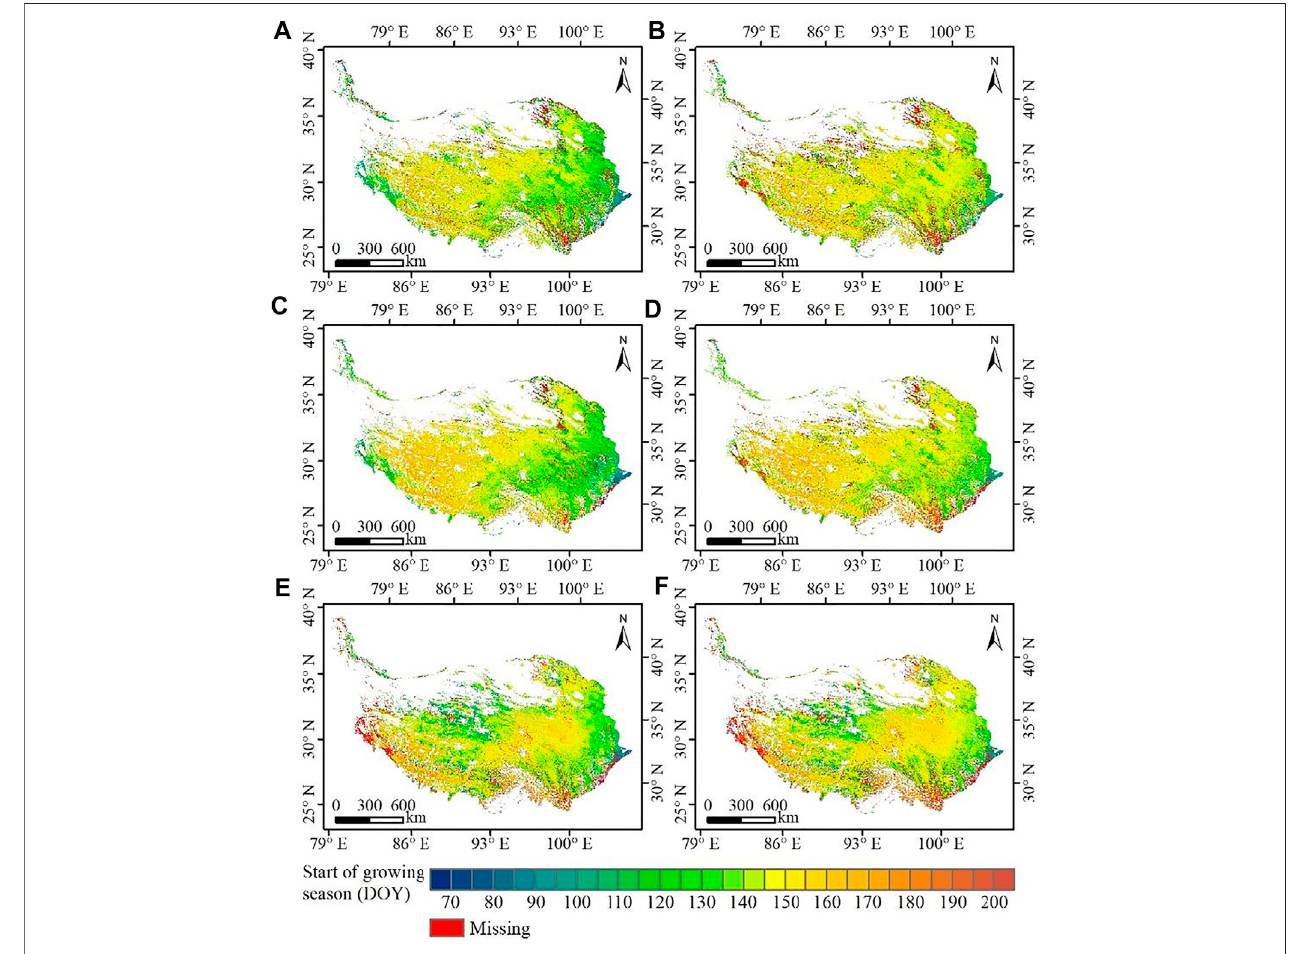
FIGURE 2 | Spatial pattern of mean start of season (SOS) between (A) E-SA, (B) E-STL, (C) N-SA, (D) N-STL, (E) P-SA, and (F) P-STL.